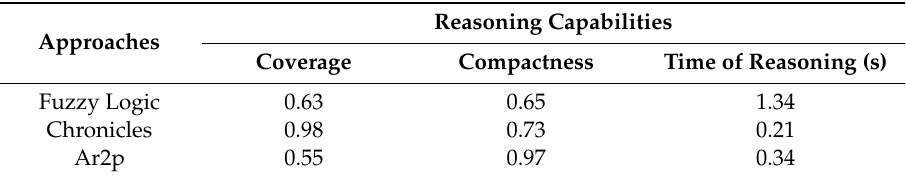
Table 11. Results for the Reasoning